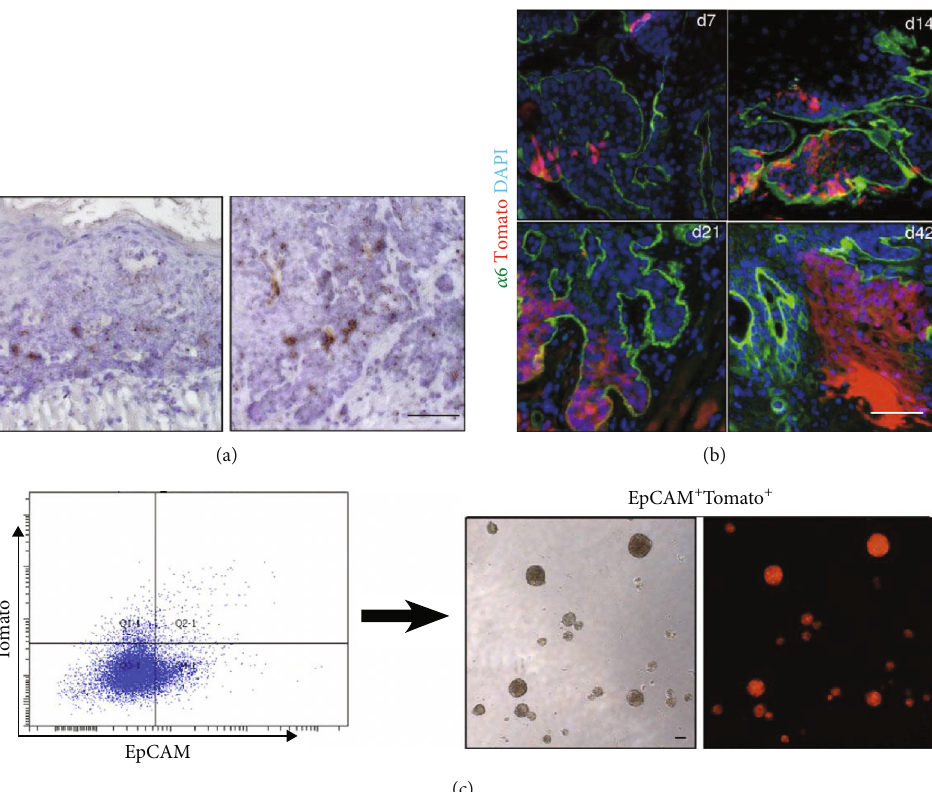
Figure 2: Bmi1 + cells and their progeny cells can self-renew in vivo and in vitro. (a) In situ hybridization of Bmi1 in ESCC samples induced by 4NQO for 15 weeks (left) and 22 weeks (right). The brown area is the expression signal of the Bmi1 gene. (b) Bmi1 + cells are labeled in Bmi1CreER;Rosa tdTomato mice following a single dose of tamoxifen and traced for 7, 14, 21, and 42 days. Red represents Tomato-positive Bmi1-expressing cells and their di ff erentiated progeny cells. Green labels integrin α 6, a marker of the epithelial basement membrane. Nuclei are labeled in blue. (c) Three days after tamoxifen injection, EpCAM + Tomato + double-positive cells sorted by fl ow cytometry were cultured into tumorspheres in vitro. Scale bars are 100 μ